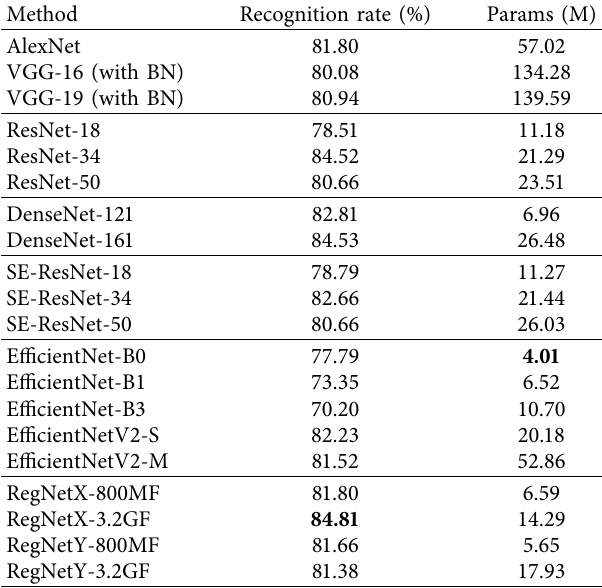
Table 9: Recognition results of different CNN methods.